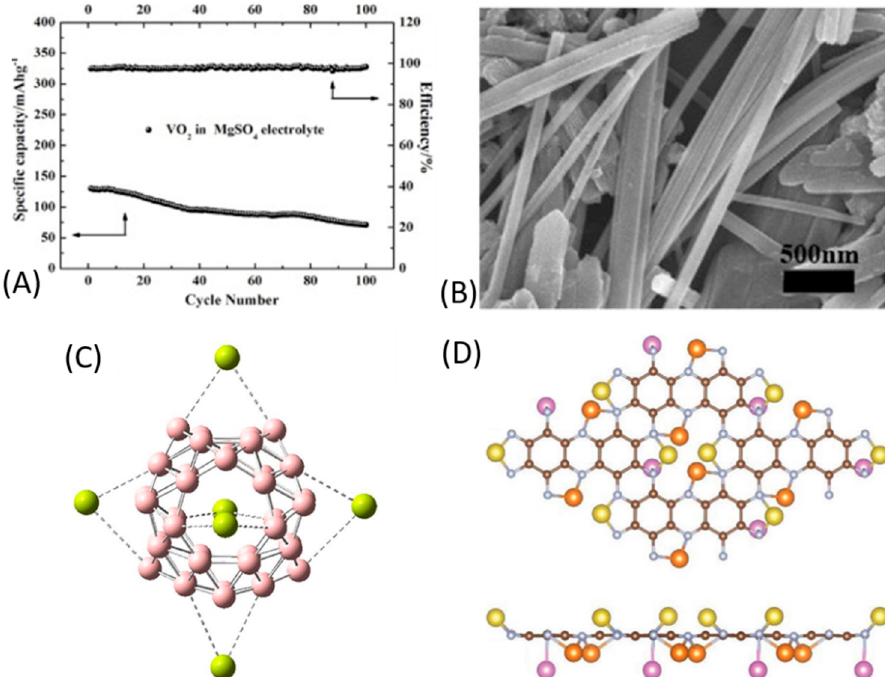
Figure 14. ( A ) Cycling properties of VO 2 NWs in MgSO 4 electrolyte; ( B ) TEM micrograph of the anode before cycling; ( C ) Relaxed geometries of fully Mg decorated of bare and halide encapsulated B 40 (B in pink, Mg in green); ( D ) Top and side views of the most stable configuration for five Mg atoms adsorption on a C 2 N monolayer (yellow, orange and pink balls denote the Mg atoms located in the top, middle and bottom layers from the side view). Adapted with permission from [183–185]. Copyright Elsevier B.V. (2019,2021) and Royal Society of Chemistry (2019).